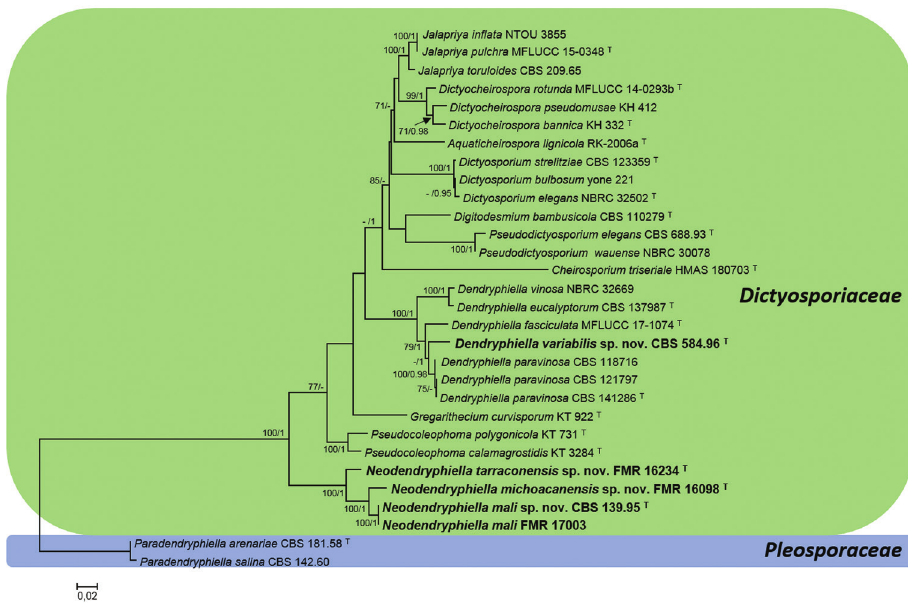
Figure 1. Maximum Likelihood (ML) tree constructed with the ITS and LSU sequences of 30 strains rep- resentatives of different taxa in the families Dictyosporiaceae and Pleosporaceae. The phylogenetic tree was rooted with Paradendryphiella arenaria and P. salina . Bootstrap support values for ML greater than 70% and Bayesian posterior probabilities greater than 0.95 are given near nodes, respectively. Names of species newly described here are indicated in bold. Branch lengths are proportional to distance. T Ex-type